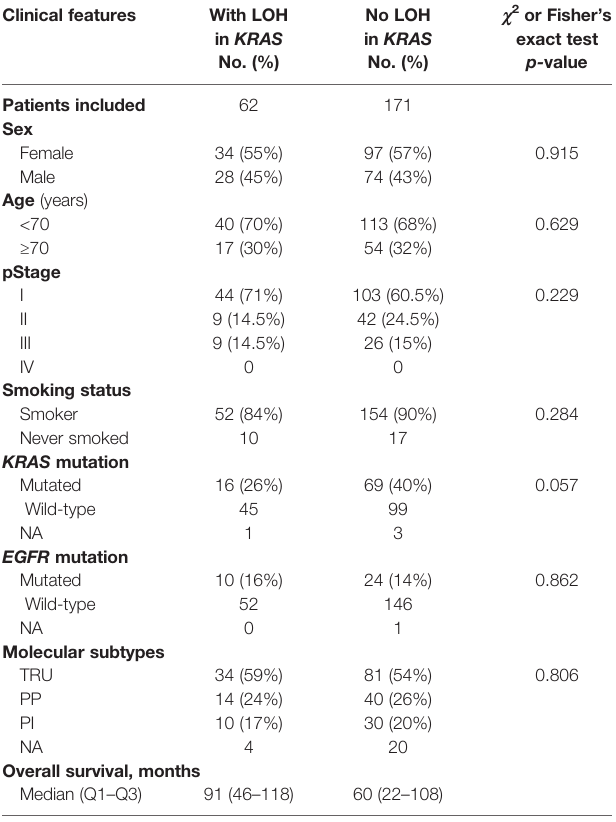
TABLE 2 | Association between KRAS LOH status and clinicopathological